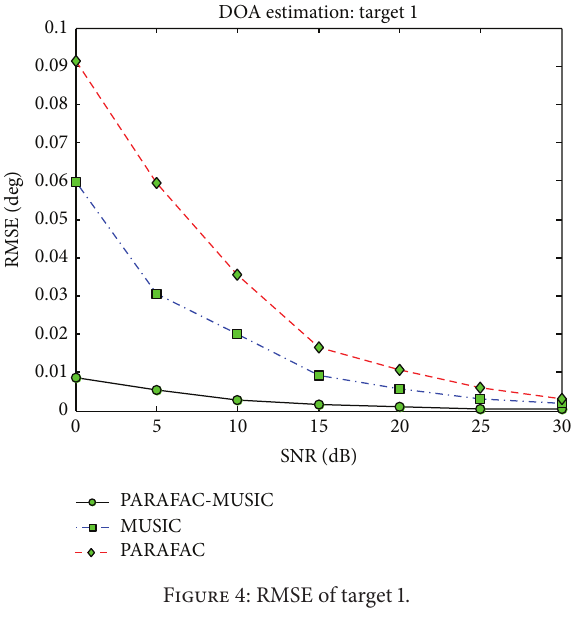
Figure 4: RMSE of target 1.